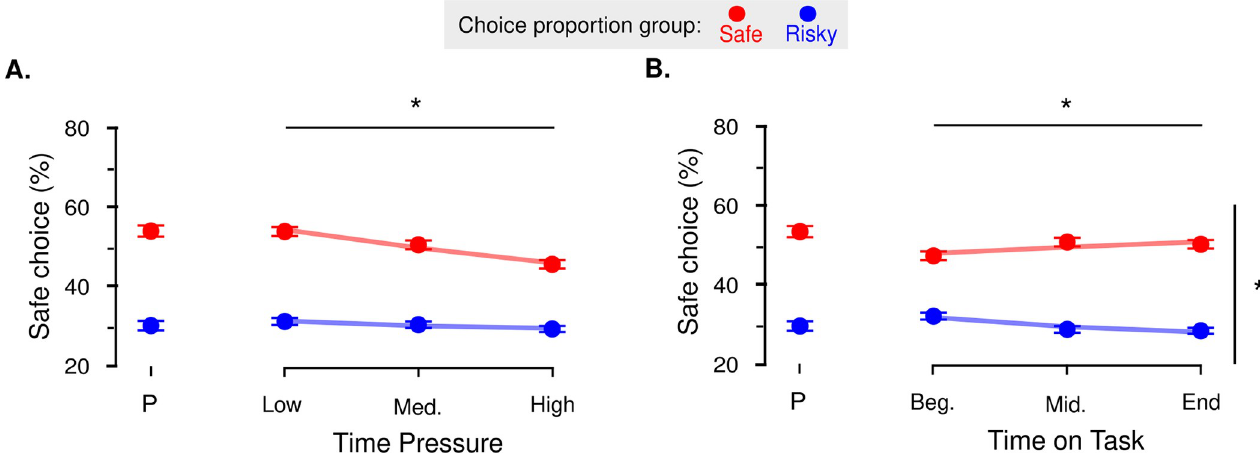
Fig 5. Observed proportion of safe choices. A. Time Pressure. Regardless of the most frequently chosen option, participants increasingly chose the risky lotteries. B. Time on Task. In the two groups, participants also learned with time to choose increasingly more the most frequently chosen option: Red and blue dots indicate data from the two groups of participants, where the safe (respectively risky) option is designed to be most frequently chosen. Dots and error bars indicate sample mean and within-subject standard error of the mean. Lines represent the average fit of the generalized linear mixed-effects regressions. � : P < 0.05 for the main effect of time pressure and the interaction between choice proportion and time on task. P: priming session.